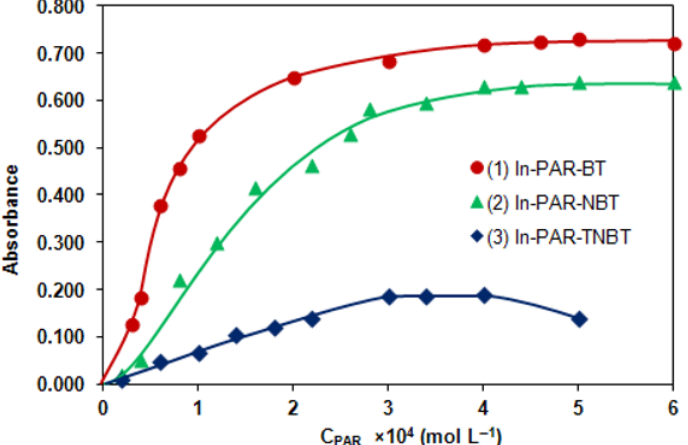
Figure 2. Absorbance of In(III)-PAR-MBT complexes in chloroform vs . pH of the aqueous phase plots. C 4.0×10 −4 mol L −1 , λ =515 nm.